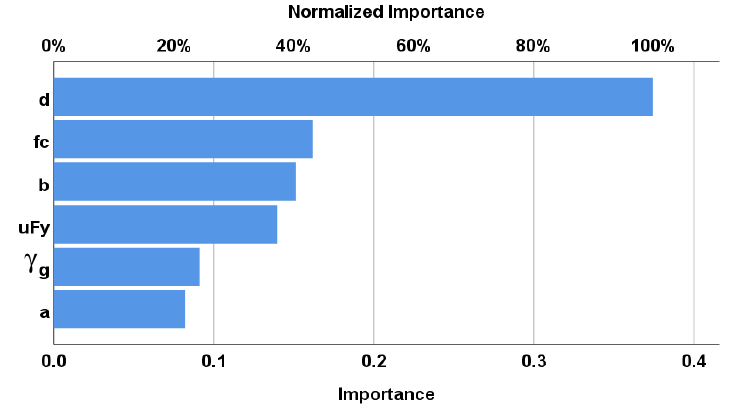
Figure 7. Relative importance of input parameters.